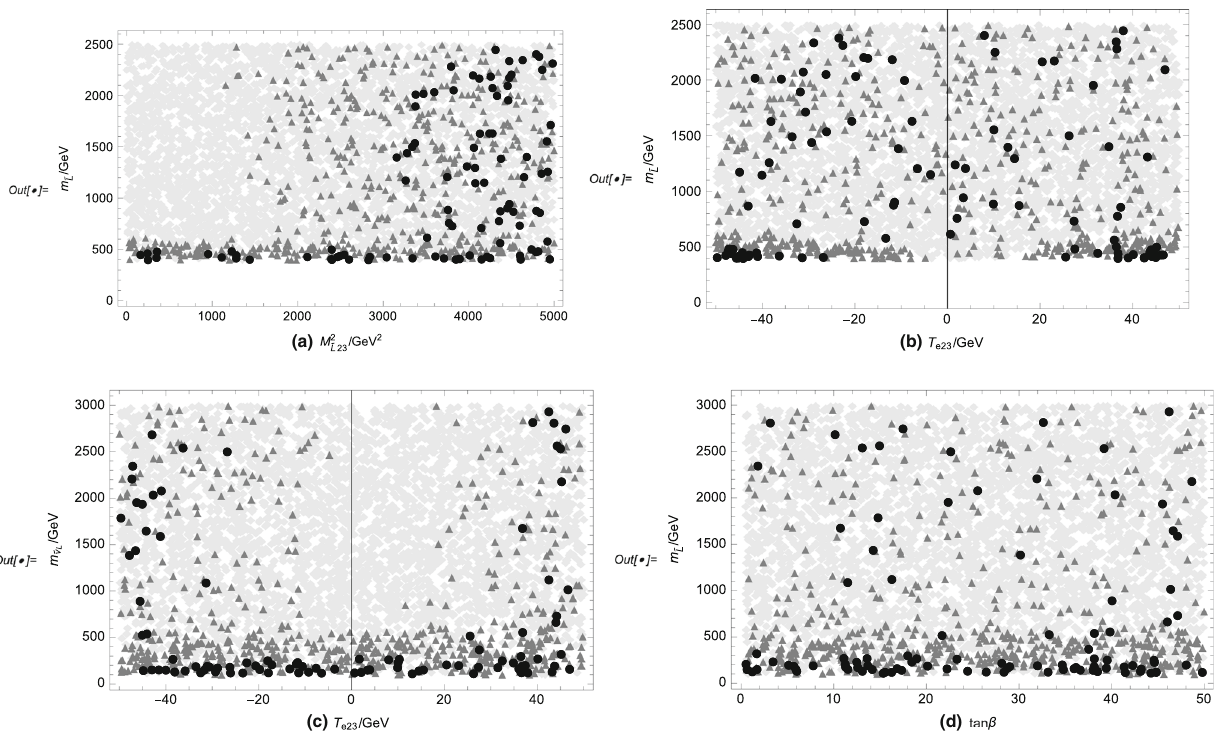
Fig. 10 Scatter points under the restriction of the upper limit of Br (τ → μγ) . (cid:2) represent 0 < Br (τ → μγ) < 1 × 10 − 10 , (cid:3) represent 1 × 10 − 10 ≤ Br (τ → μγ) < 9 × 10 − 10 and 9 × 10 − 10 ≤ Br (τ → μγ) < 4 . 4 × 10 − 8 are represented by